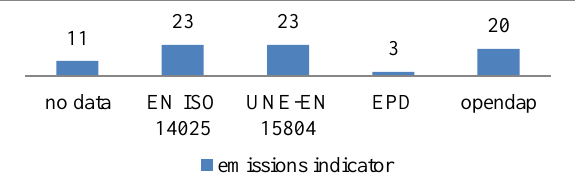
Figure 10. Stone and soil category.